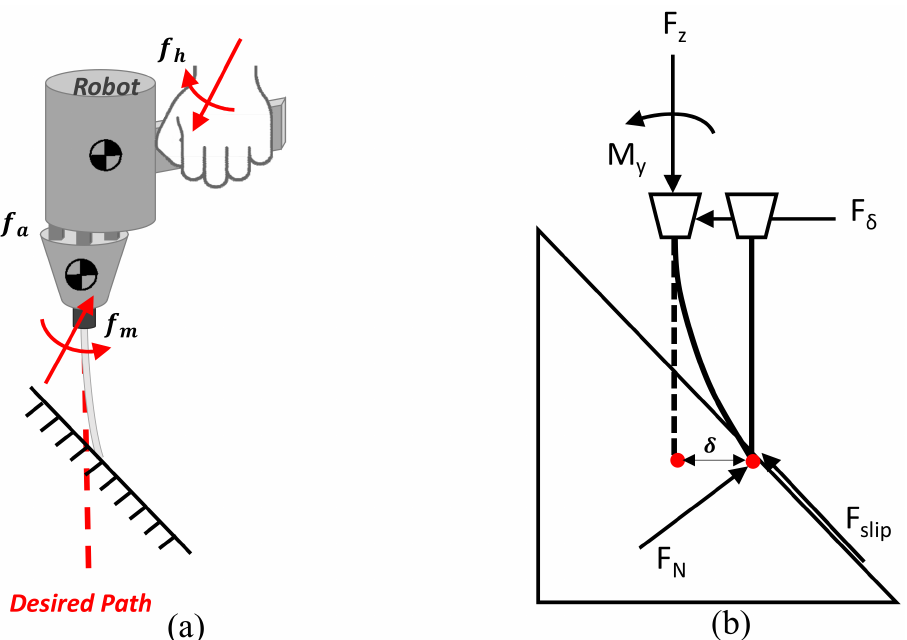
Figure 2. ( a ) The compensation action of the robot causes the drill to bend. At the same time, the deflection force of the drill tool is also reflected to the handle and felt by the operator, ( b ) the deflection model of the drill tool in contact with the object surface.